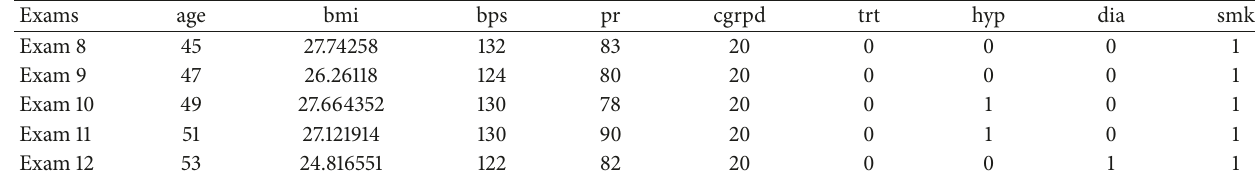
Table 9: Exam data for Sample 2: male with CVD and diabetes.